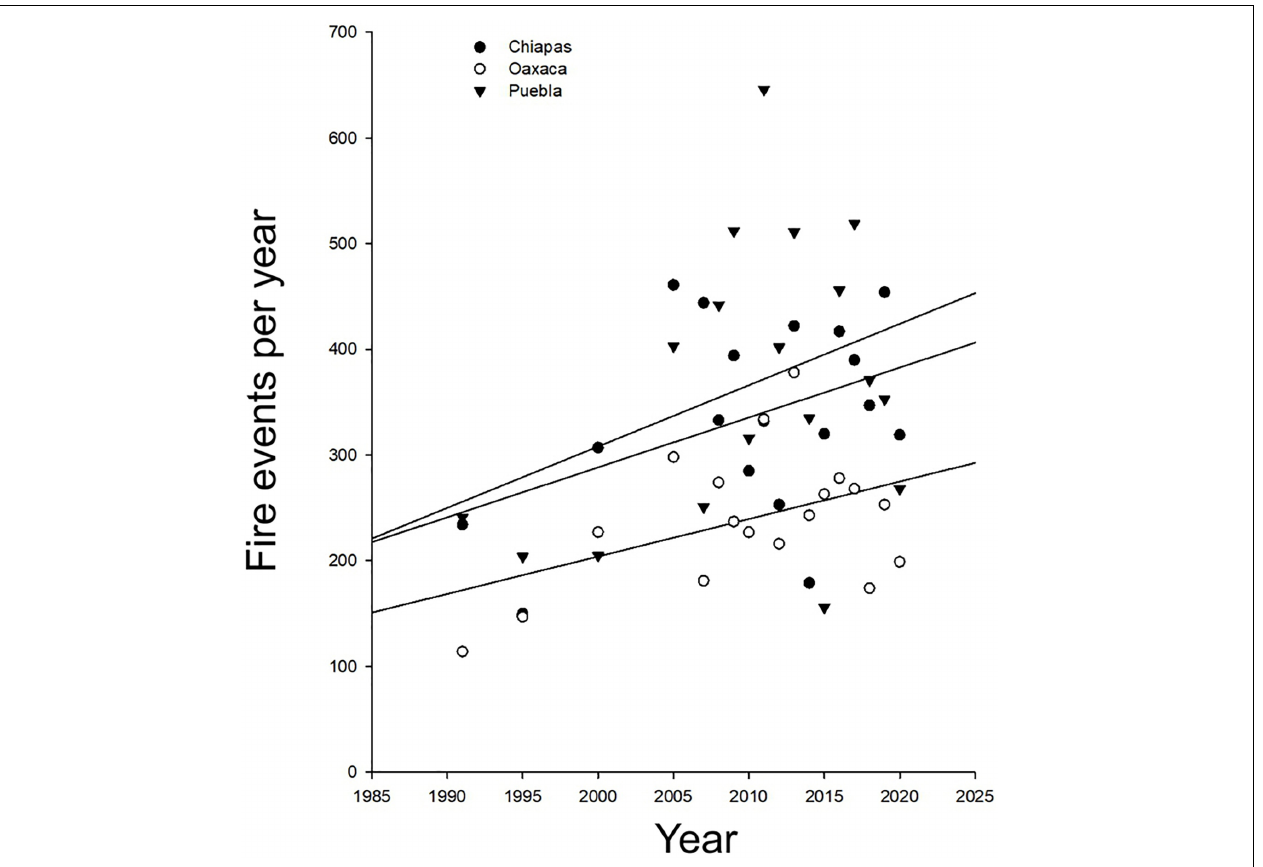
FIGURE 5 | Forest fires per year in the three mountainous states of southern Mexico: Puebla, Oaxaca, and Chiapas from 1995 to 2020. Data from Comisión Nacional Forestal [CONAFOR], and Secretaría de Medio Ambiente y Recursos Naturales [SEMANART] (2021). Fire frequency has significantly increased in recent decades, from 1995 to 2020, in Puebla, Oaxaca, and Chiapas [ F ( 1 , 50 ) = 10.26, P = 0.002]. Fire incidence was significantly different among these states [ F ( 2 , 50 ) = 9.11, P = 0.0004]. However, the non-significant state-by-year interaction suggests that common factors act in similar ways in the observed increase in fire events in these